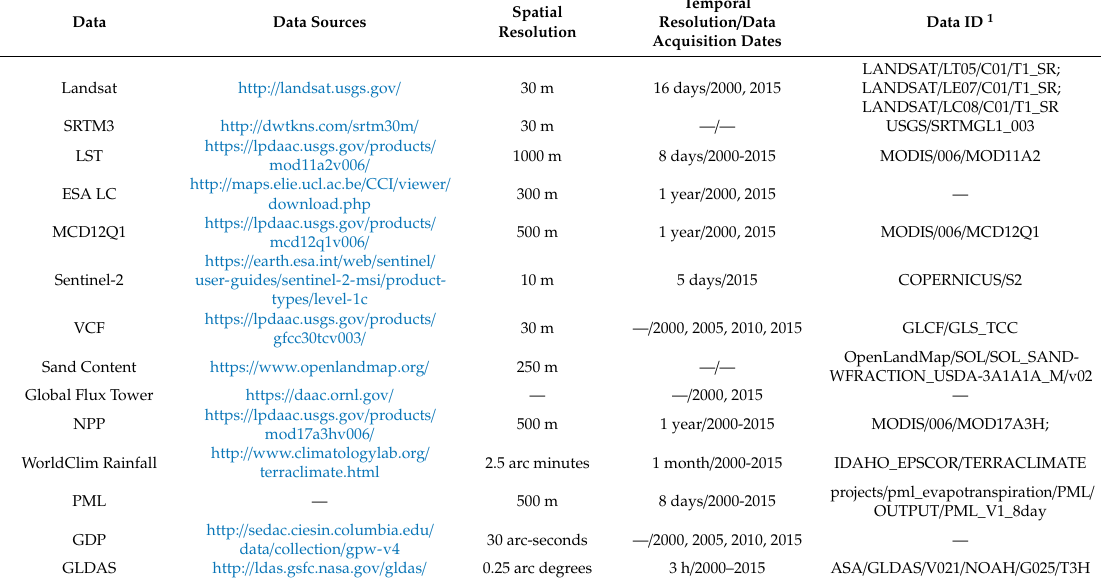
Table 1. Basic datasets.